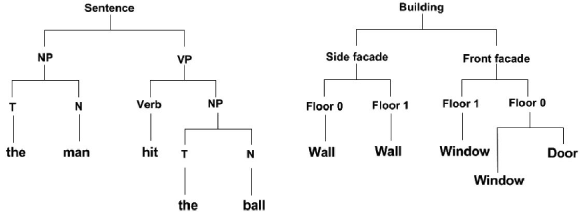
Figure 1. Chomsky context-free grammar concept and its adap- tation for buildings according to Stiny and